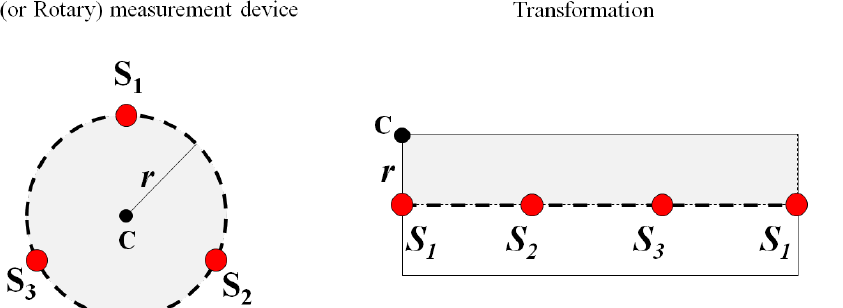
Figure 17. Generation of thickening form of the target plant (initial